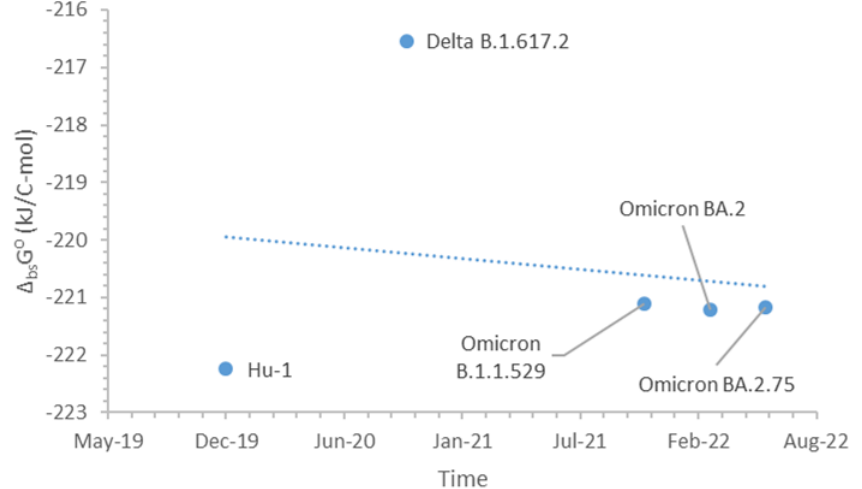
Figure 1. Standard Gibbs energy of biosynthesis during the evolution of the SARS-CoV-2 variants. The graph shows the standard Gibbs energy of biosynthesis, ∆ bs G 0 , of the SARS-CoV-2 variants versus the time they appeared. The dotted line shows the trend of evolution in the multiplication rate of the SARS-CoV-2 variants.